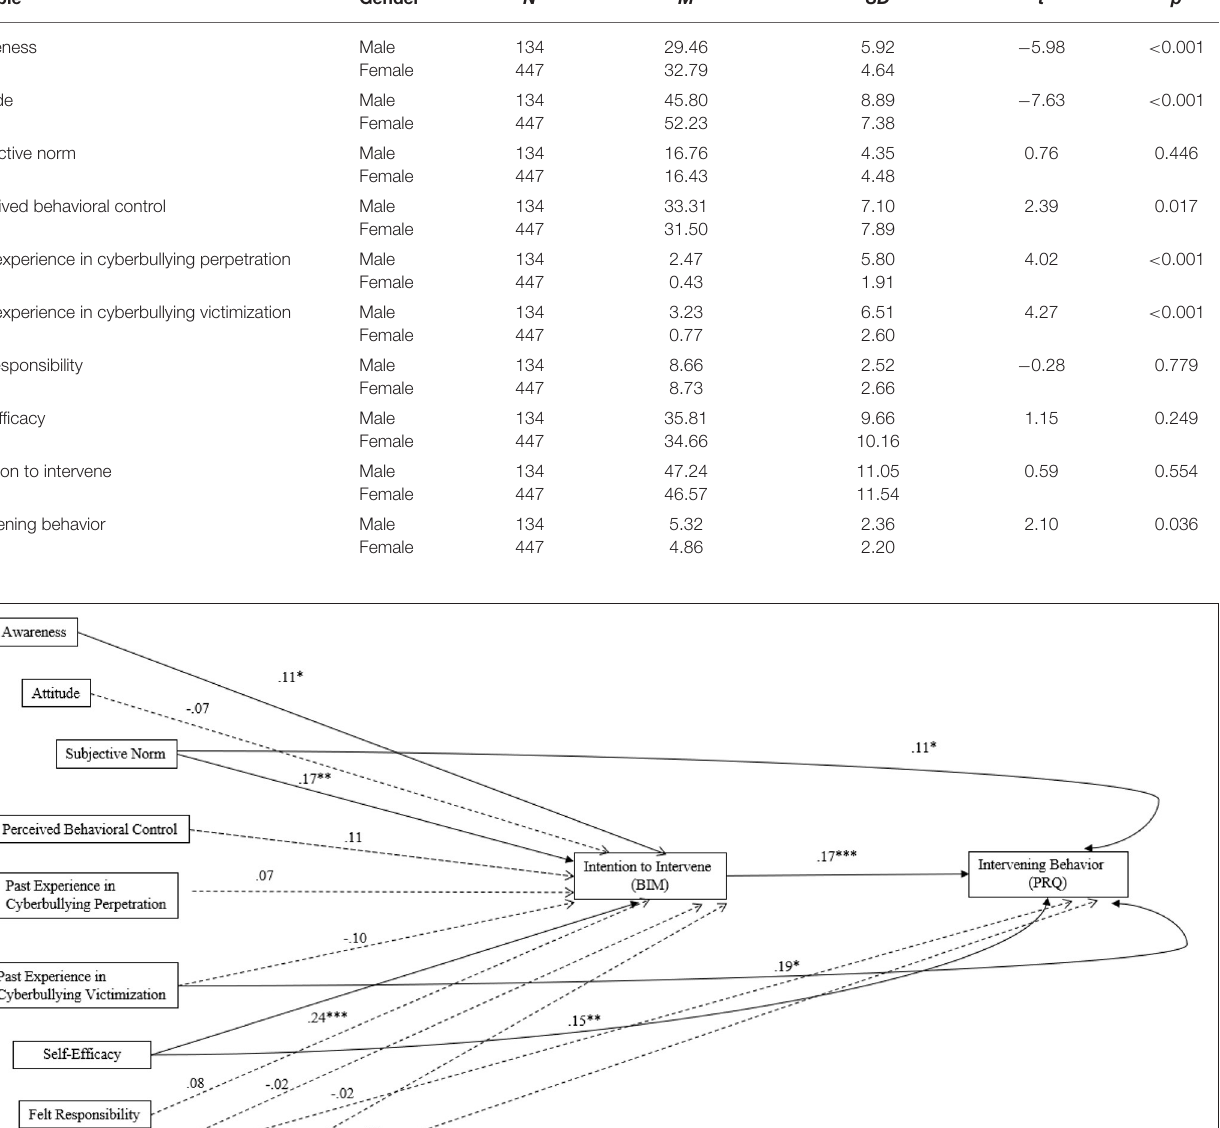
TABLE 3 | Independent samples t -test comparing gender differences in study variables. Variable